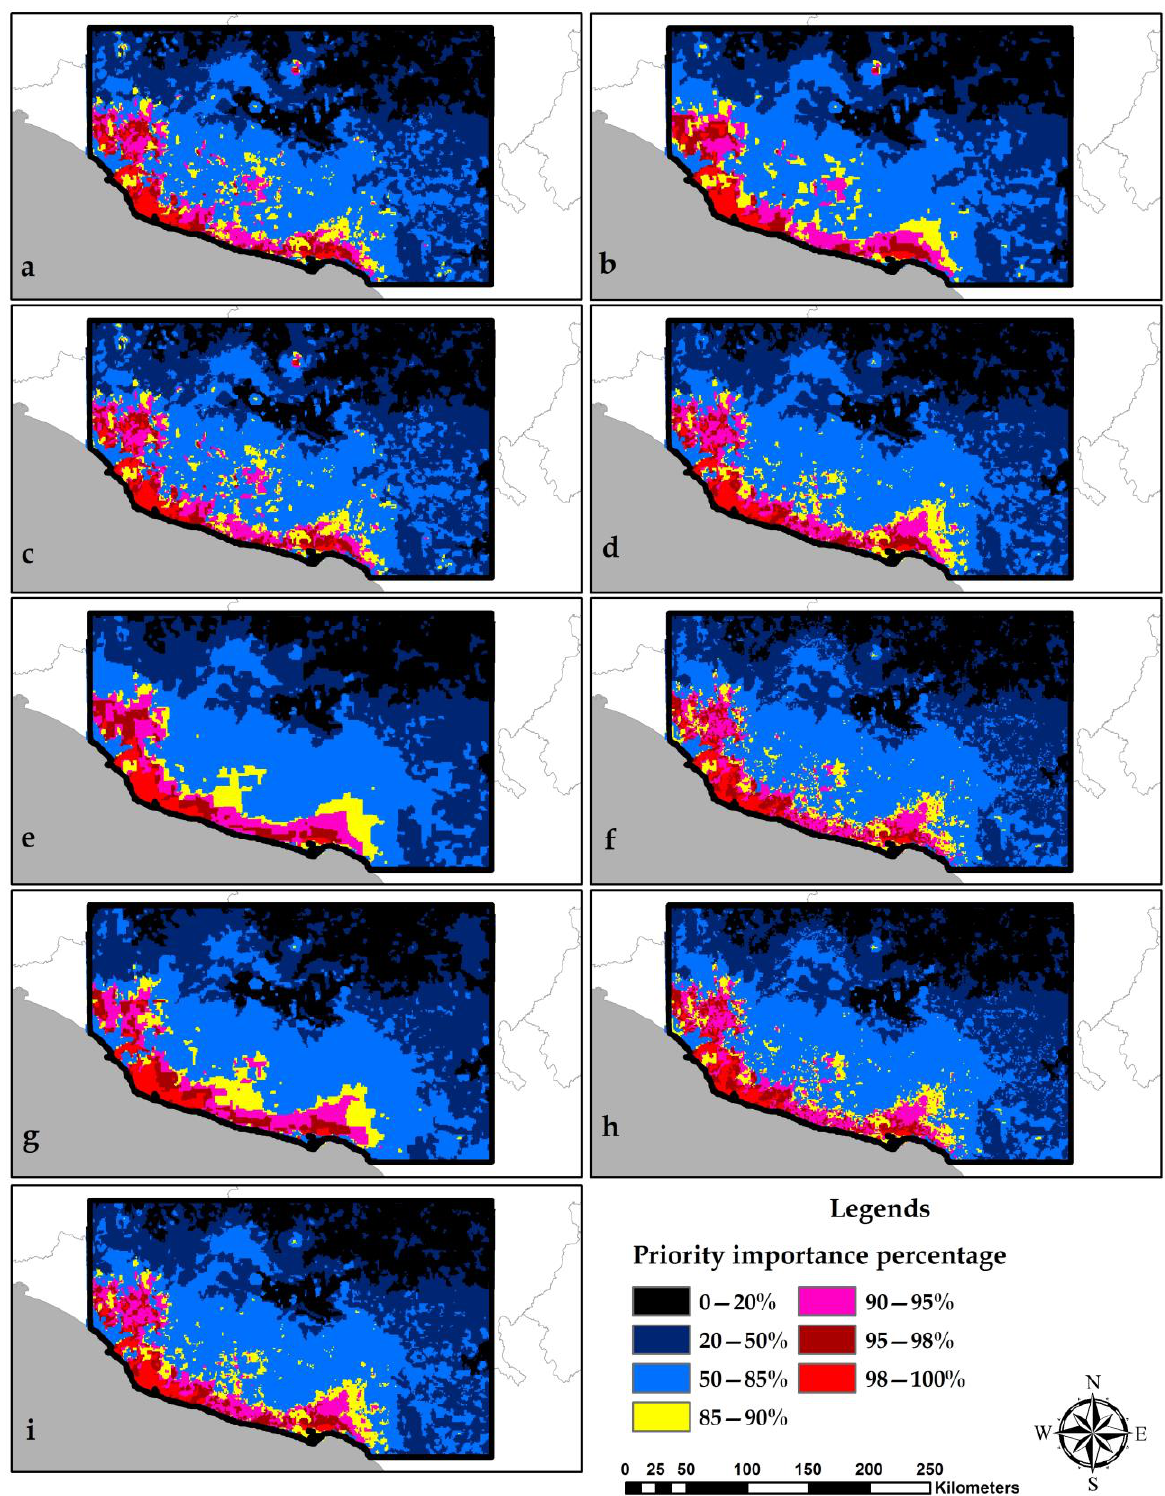
Figure A5. Prioritization (zonation) models, applying the additive benefit function (ABF) elimina- tion rule. ( a ) Only ABF, ( b ) ABF and BLP (boundary length penalty), ( c ) ABF — smoothed function, ( d ) ABF —species’ weights, ( e ) ABF —species’ weights— BLP, ( f ) ABF —species’ weights— inverted deforestation, ( g ) ABF —species’ weights— inverted deforestation — BLP, ( h ) ABF —species’ weights — inverted deforestation — smoothed function; ( i ) CAZ — species; weights — smoothed func- tion.